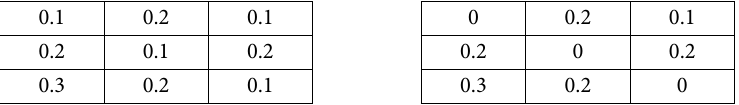
Table 2. The initial agglomeration (left) and the trust fused agglomeration (right)